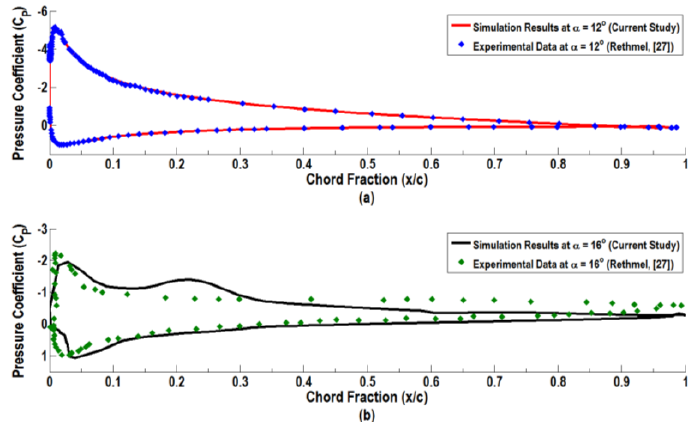
Figure 11. Comparison of predicted pressure coefficients around the airfoil at angle of attack (AoA) = 12° and AoA = 16° with the experimental data of Rethmel [27].